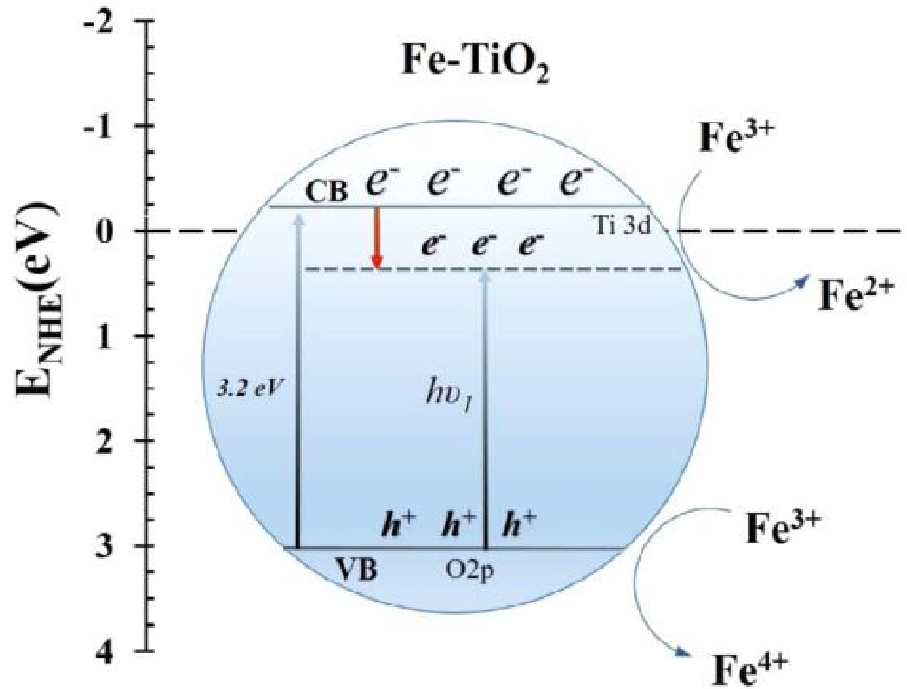
Figure 7. Schematic diagram showing the energy levels of TiO 2 doped with Fe (transition metal). Reprinted/adapted with permission from Ref. [147]. 2018, Elsevier.